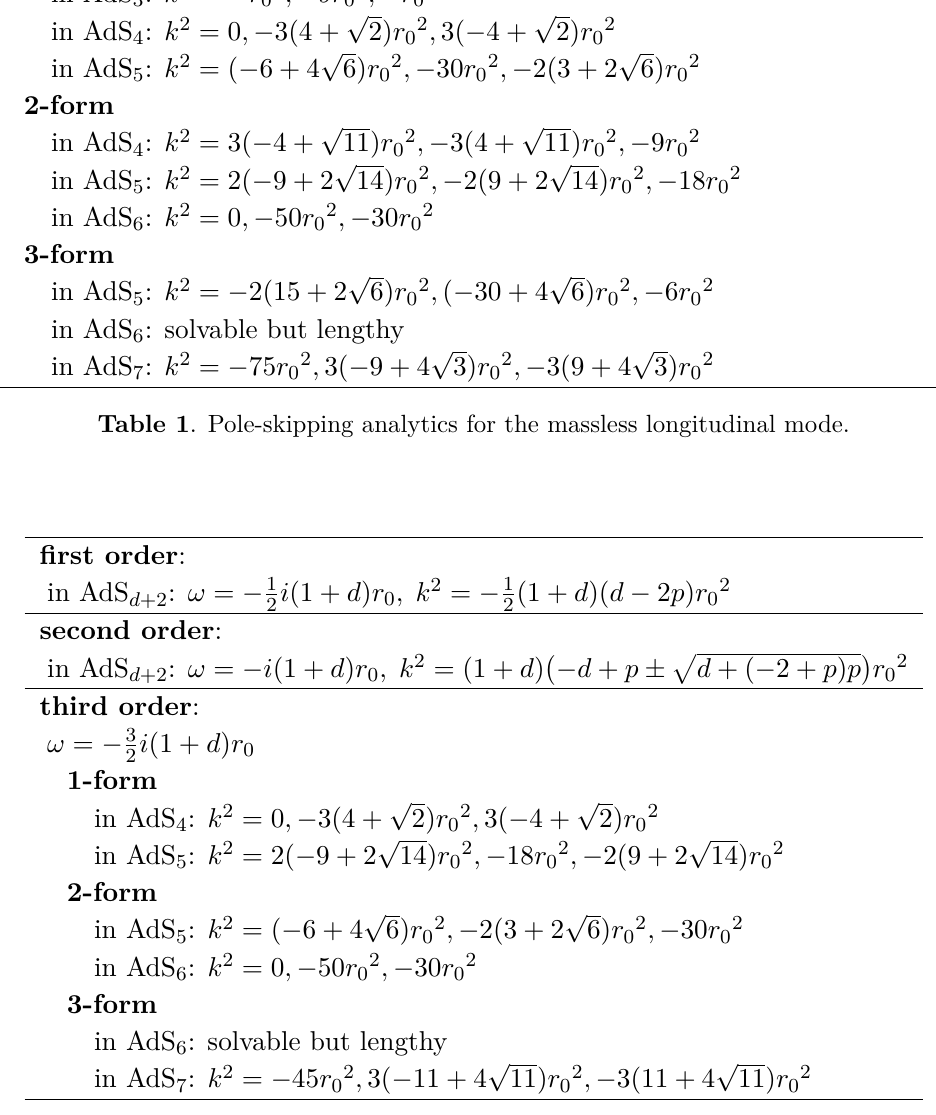
Table 2 . Pole-skipping analytics for the massless transverse